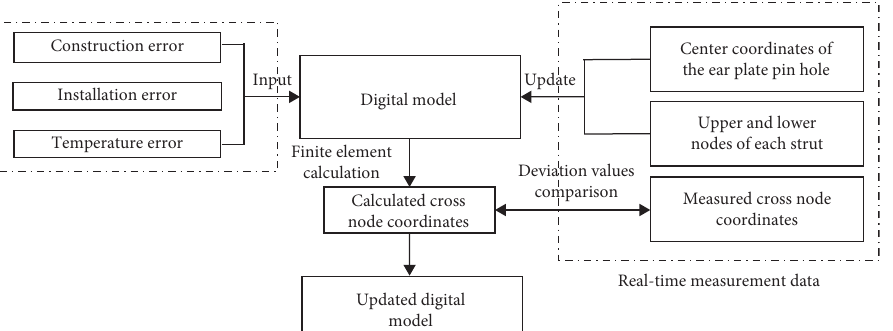
Figure 7: Update model process flowchart.